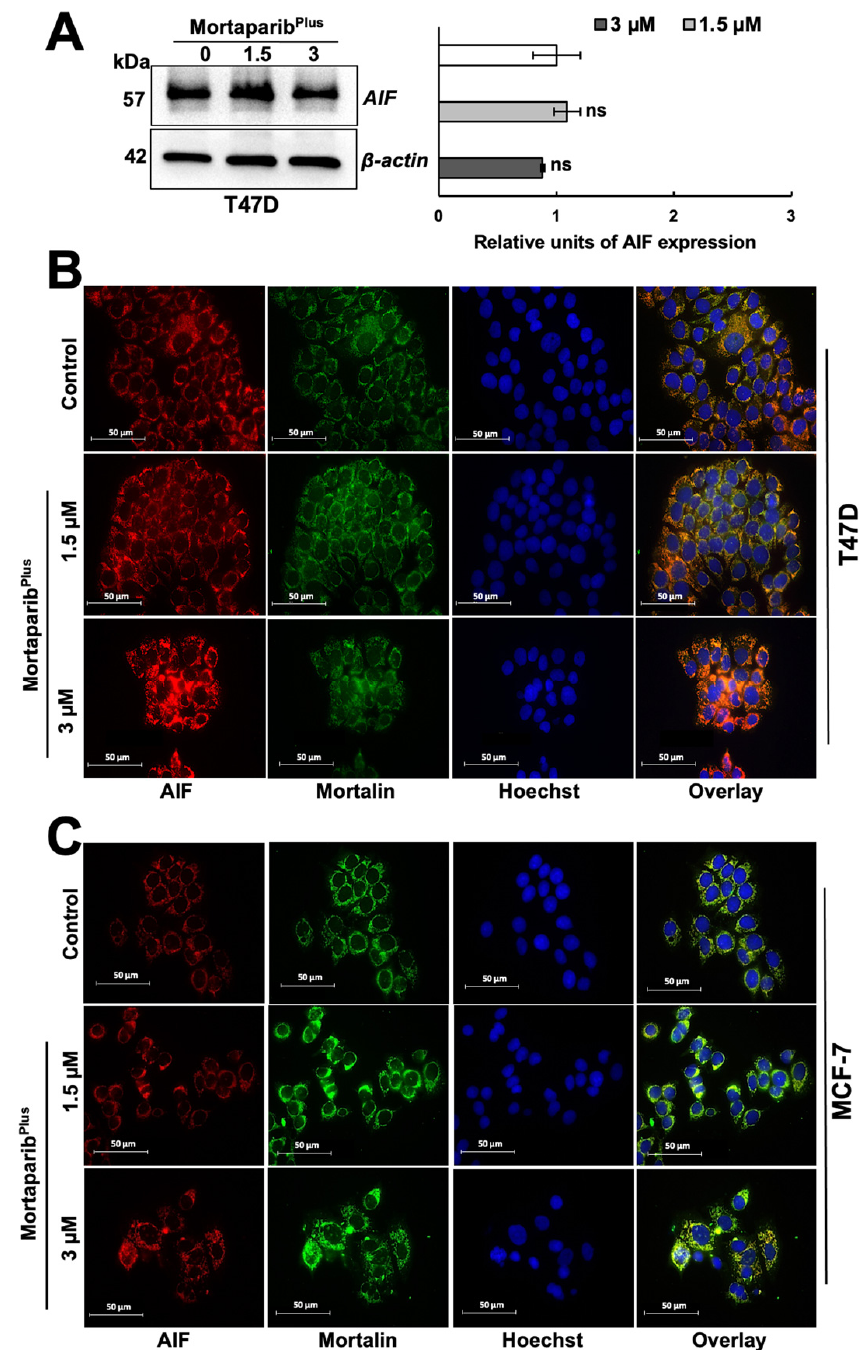
Figure 7. Mortaparib Plus treated cells did not show translocation of apoptosis-inducing factor (AIF) to the nuclei. AIF’s expression level in control and 48 h Mortaparib Plus -treated T47D cells was examined by Western blotting ( A ). There were no significant changes in AIF’s expression levels in control and Mortaparib Plus -treated T47D cells. AIF’s subcellular localization in control and 48 h-Mortaparib Plus -treated T47D and MCF-7 cells was analyzed by immunocytochemistry. Co-localization of mortalin and AIF was observed in T47D cells ( B ). MCF-7 cells showed a low level of expression of AIF as compared to T47D cells; its colocalization with mortalin was observed and more prominent in Mortaparib Plus -treated cells ( C ). Full uncropped blots for the Western blotting experiments are shown in Supplementary Figure S18. Scale bar: 50 mm. The quantified data represent mean ± SD obtained from independent biological replicates; p -values were calculated using unpaired Student’s t -test. ns > 0.05 represents